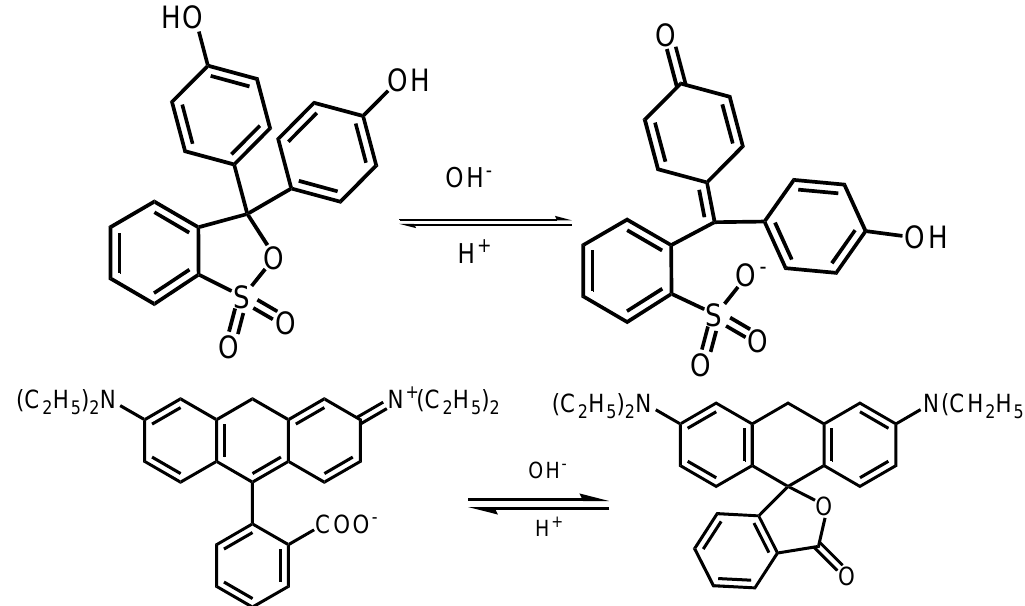
Figure 10. The effect of pH on the ionization of phenol red and rhodamine B.